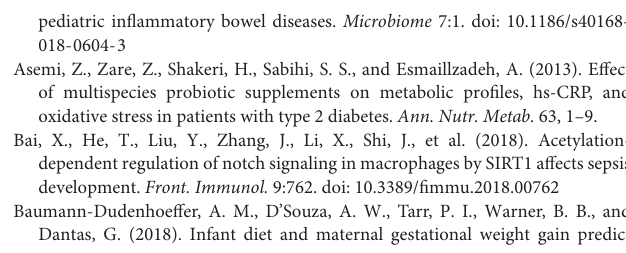
Supplementary Figure 1 | The effect of different doses of S. thermophilus 19 on cell viability was detected by CCK8 assay after co-culture of 6 h ( n = 6). Error bars represent SEM. ∗ P < 0.05, ∗∗ P < 0.01, Compared with PBS group. Supplementary Figure 2 | The influence of S. thermophilus 19 and LPS on body weight, total rat chow, and drinking water intake. (A) Body weight change and relative weight change ( n = 8/group). (B) Total rat chow intake. (C) Total drinking water. ∗ P < 0.05, Compared with PBS group. Supplementary Figure 3 | The presence of S . thermophilus 19 induces changes in gut microbiota function after LPS treatment ( n = 8/group). Statistical comparison was performed by first testing normality using Kruskal–Wallis/Wilcoxon rank-sum test. Error bars represent SEM. Supplementary Figure 4 | The correlation between the bacterial composition with the inflammatory factors ( n = 8/group). The calculated data were submitted to corrplot R package to generate the correlation plot with the Significant confidence interval of